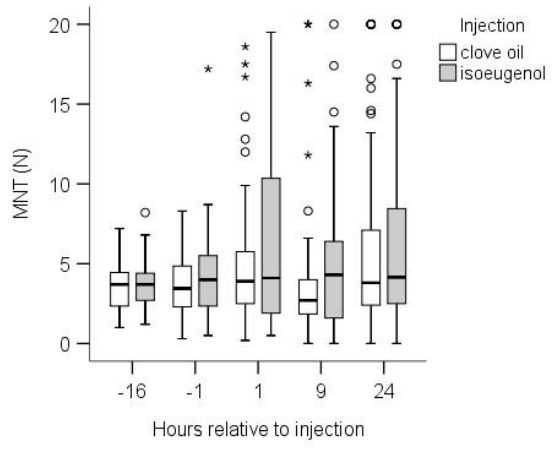
Figure 3. Mechanical nociceptive threshold of the 20 calves on the five time points (TP) the day before, i.e., about 16 h before ( − 16), injection of clove oil (white boxes) or isoeugenol (grey boxes), on injection day 1 h before ( − 1), about 1 (1) and 9 h (9) after injection, and 24 h after injection (24). The value 20 N